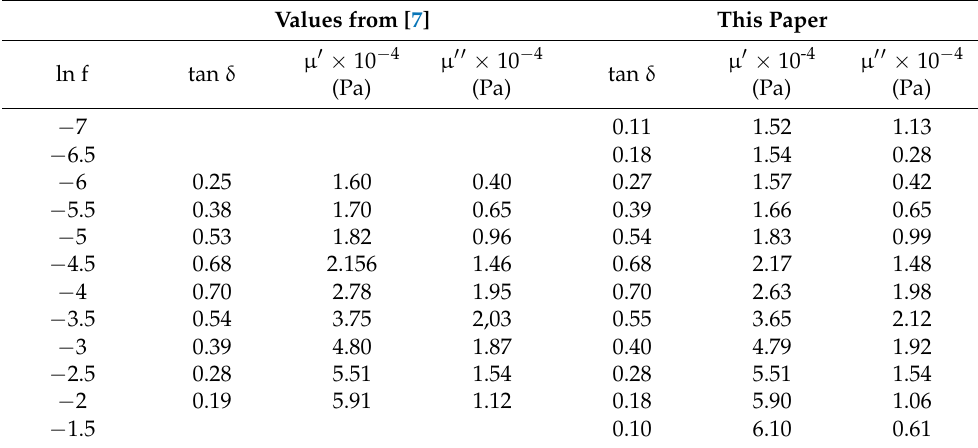
Table 1. Calculated values for viscoelastic parameters as a function of the frequency. Values from